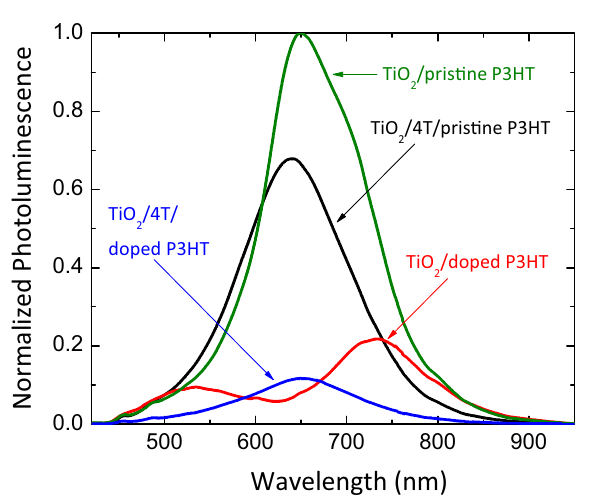
Figure 5. Normalized Photoluminescence (PL) spectra of TiO 2 /P3HT, TiO 2 /4T/P3HT, TiO 2 /doped P3HT and TiO 2 /4T/doped P3HT films. Here, the interface of TiO 2 /P3HT, TiO 2 /doped Spiro and TiO 2 /doped P3HT were modified with 4T